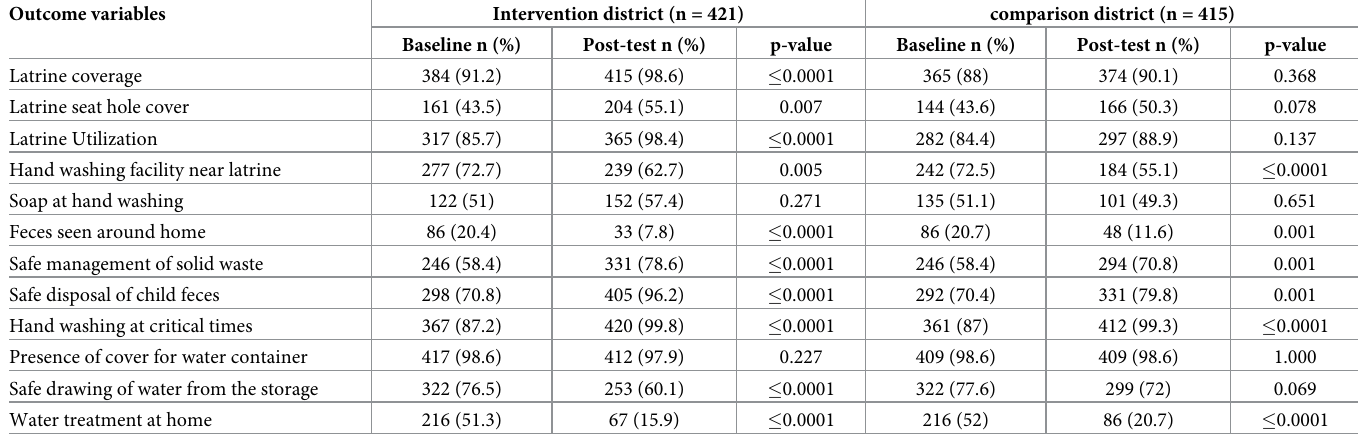
Table 3. Prevalence of behavioral and environmental factors associated with diarrheal disease in intervention and comparison districts, Jimma zone, Oromia region, Ethiopia, 2019 (N = 836). Outcome variables